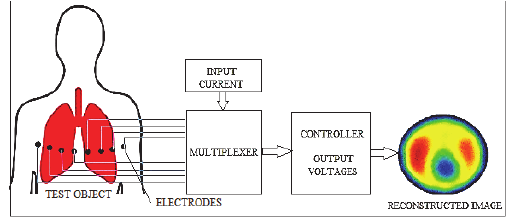
Fig. 1: General block diagram of an EIT system. The input current is injected through a pair of electrodes attached to the test object. The corresponding output voltages are measured and finally an image of conductivity distribution is